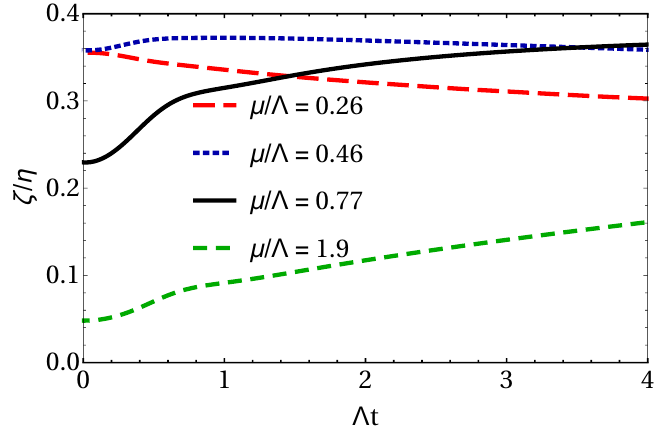
Figure 6 . Early-time evolution of the (cid:16)=(cid:17) ratio for runs with (cid:30) shown include times before and after